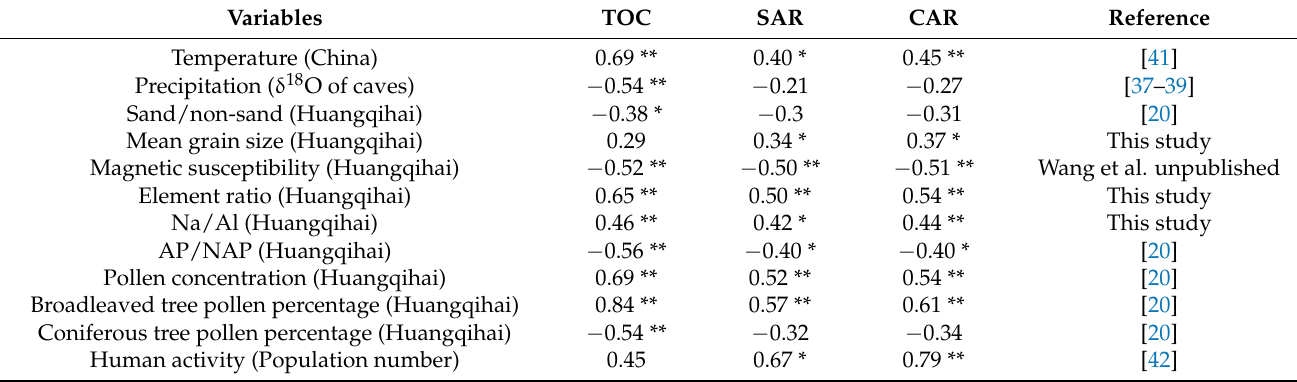
Table 2. Correlation coefficients ( R ) of Huangqihai Lake sediment TOC, SAR, and CAR with climate/environmental variables.